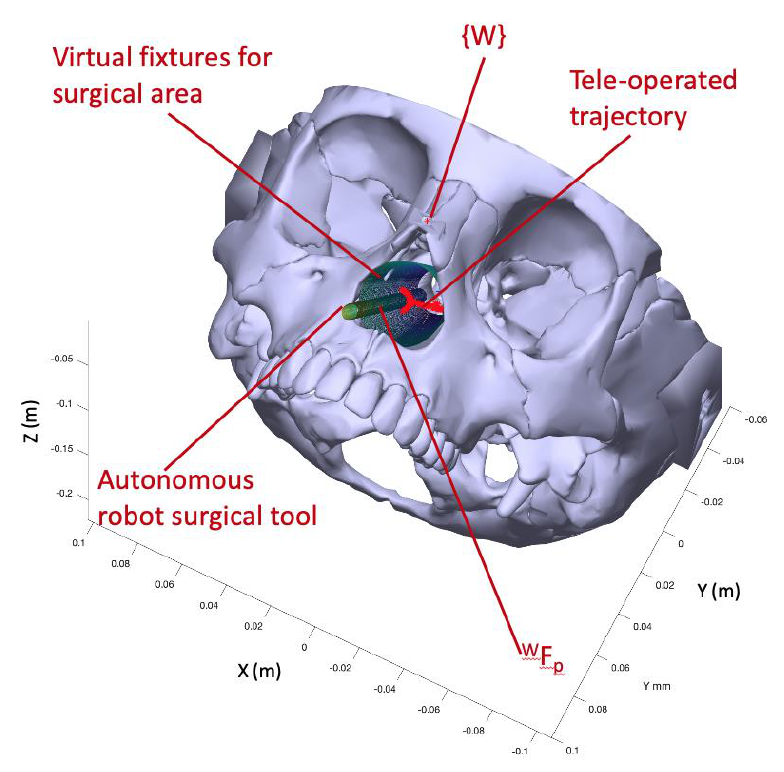
Figure 11. Proposed scenario for teleoperated navigation test.